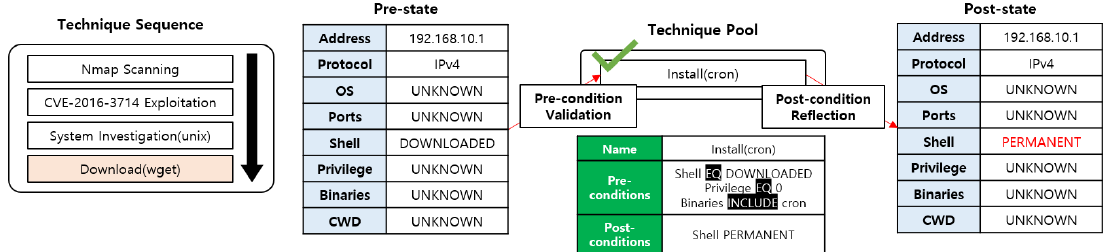
Figure 5. The example of the process of scenario generation: remote access tool (RAT) download chosen.